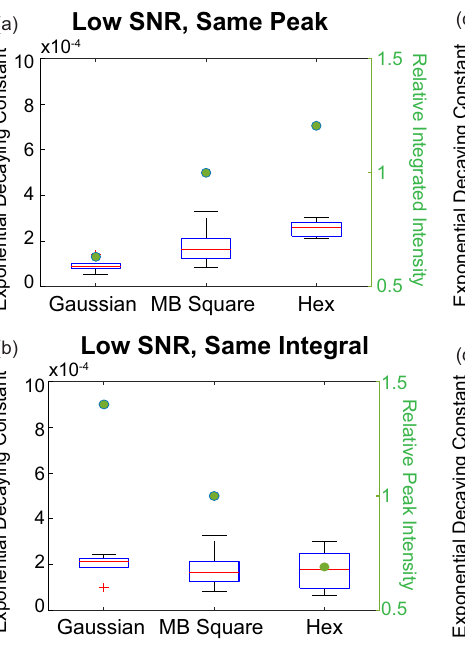
the secondary right axis and indicate the relative integrated (or peak) intensity compared with MB-square lattice when the three beams share either the same relative peak (or integrated) intensity. c , d Photobleaching comparisons similar to ( a , b ), but acquired with higher illumination intensities (( ∼ 0.033 µ W/ µ m 2 at the sample for low SNR vs. ∼ 0.1 µ W/ µ m 2 at the sample for high